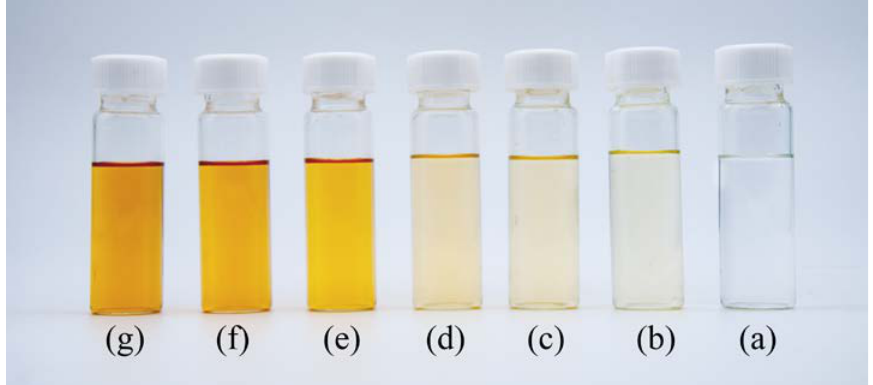
Figure 4. The color changes of IPBC in acetonitrile during thermal degradation at 140 °C for different heating times: ( a ) 0 min; ( b ) 10 min; ( c ) 20 min; ( d ) 30 min; ( e ) 40 min; ( f ) 50 min; and ( g ) 60